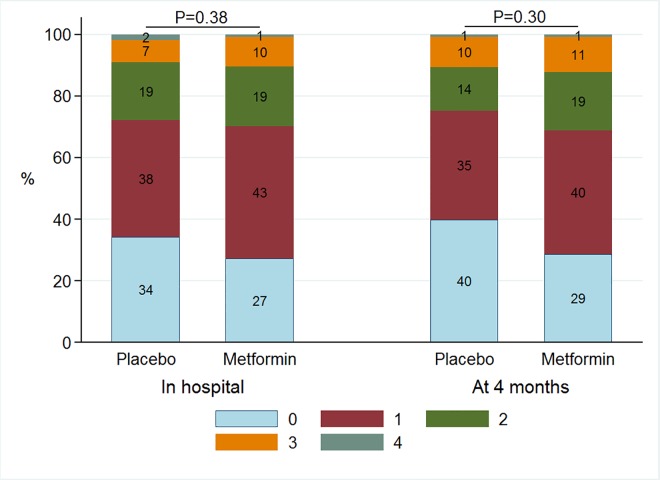
Barchart of prevalence of abnormal individual parameters of diastolic function during hospitalization and at 4 months according to randomization.